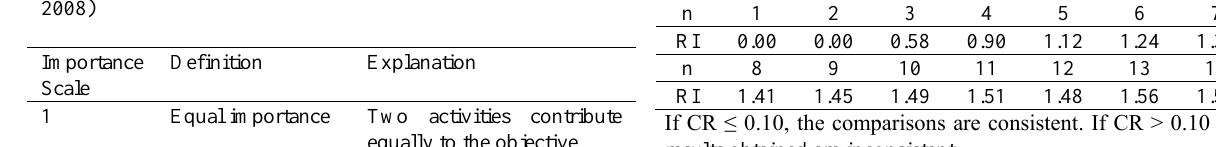
Figure 2. Hierarchical structure of criteria Construction of Pairwise Comparison Matrices: Pairwise comparison matrices are created for each criterion. The scale 1. Table 1. Pairwise comparison scale in AHP method (Saaty,